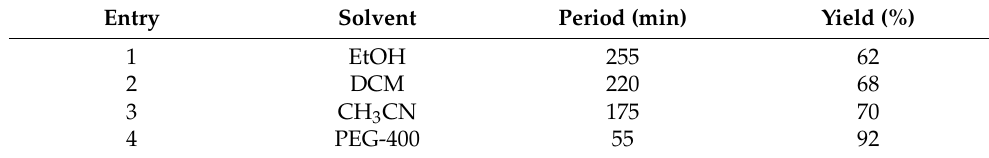
Table 2. Effects of solvent on outcome of the reaction of 1,5-benzothiazepine derivatives at 60 ◦ C. Entry Solvent Period